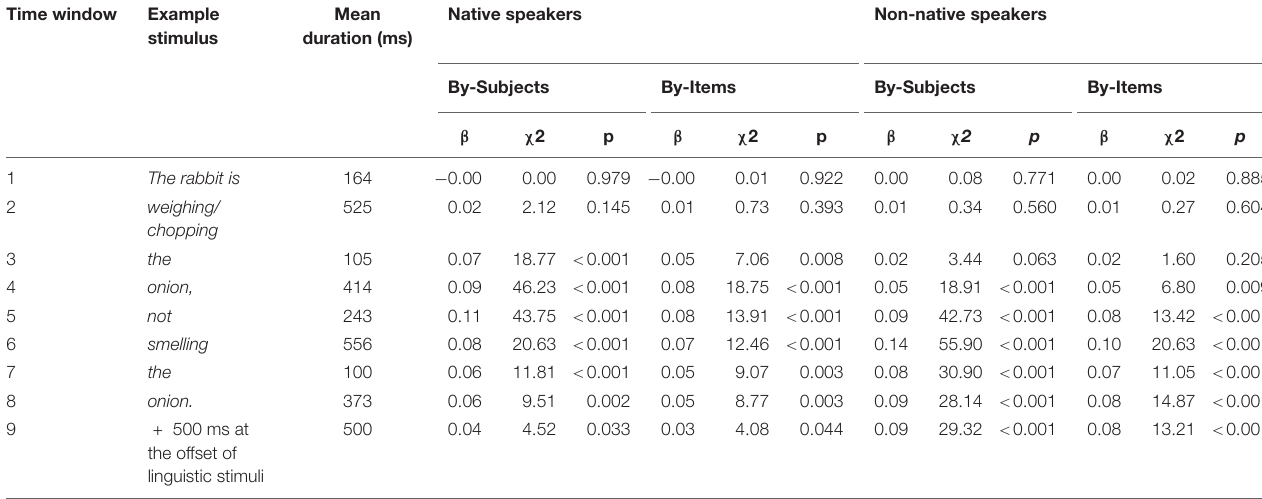
TABLE 2 | Results of linear mixed models. Time